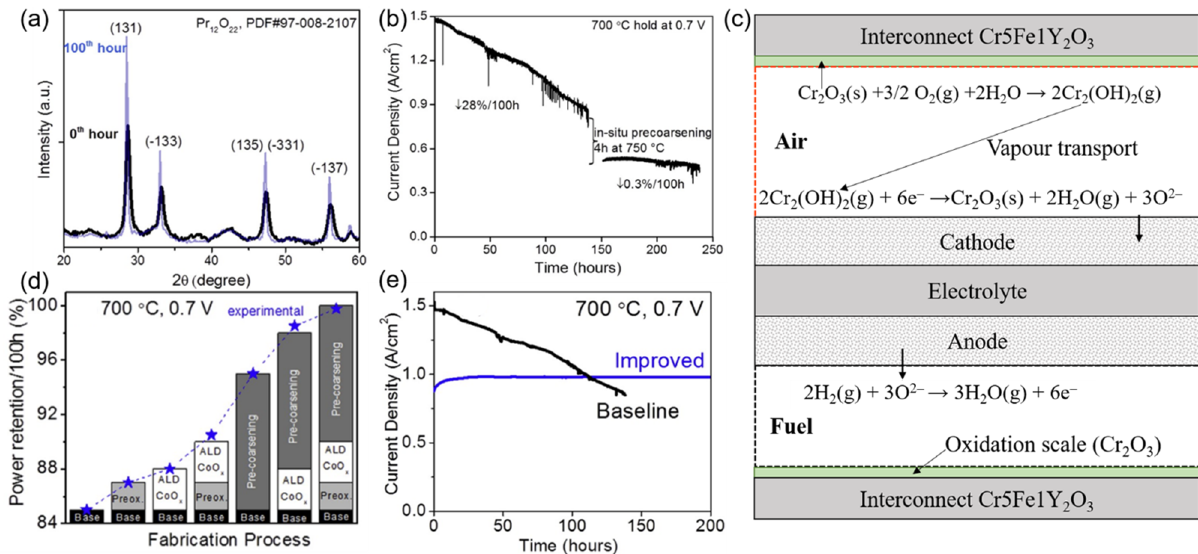
Figure 14. ( a ) Powder X-ray diffraction on PrOx cathode catalyst calcined at 600 °C (black) and after thermal annealing at 700 °C (blue) in the air for 100 h; ( b ) Impact of in situ catalyst pre-coarsening. MS-SOFC durability at 700 °C and 0.7 V before and after in situ catalyst pre-coarsening at 750 °C for 4 h; ( c ) Cr transport at the cathode side of a SOFC; ( d ) Bars represent quantified power retention (percentage of remaining power density after 100 h of operation vs. the beginning of life) observed for the post-sintering fabrication processes, individually and combined. Each process is associated with different colours and marking. Experimental results from whole cells are overlaid (blue stars). ( e ) Long-term durability for baseline and improved cell (after the cathode pre-coarsening, metal support pre-oxide, and ALD process) at 700 °C and 0.7 V. ( a , b , d and e )were reproduced with permission from Ref [52]; ( c ) was adapted with permission from Ref [116].